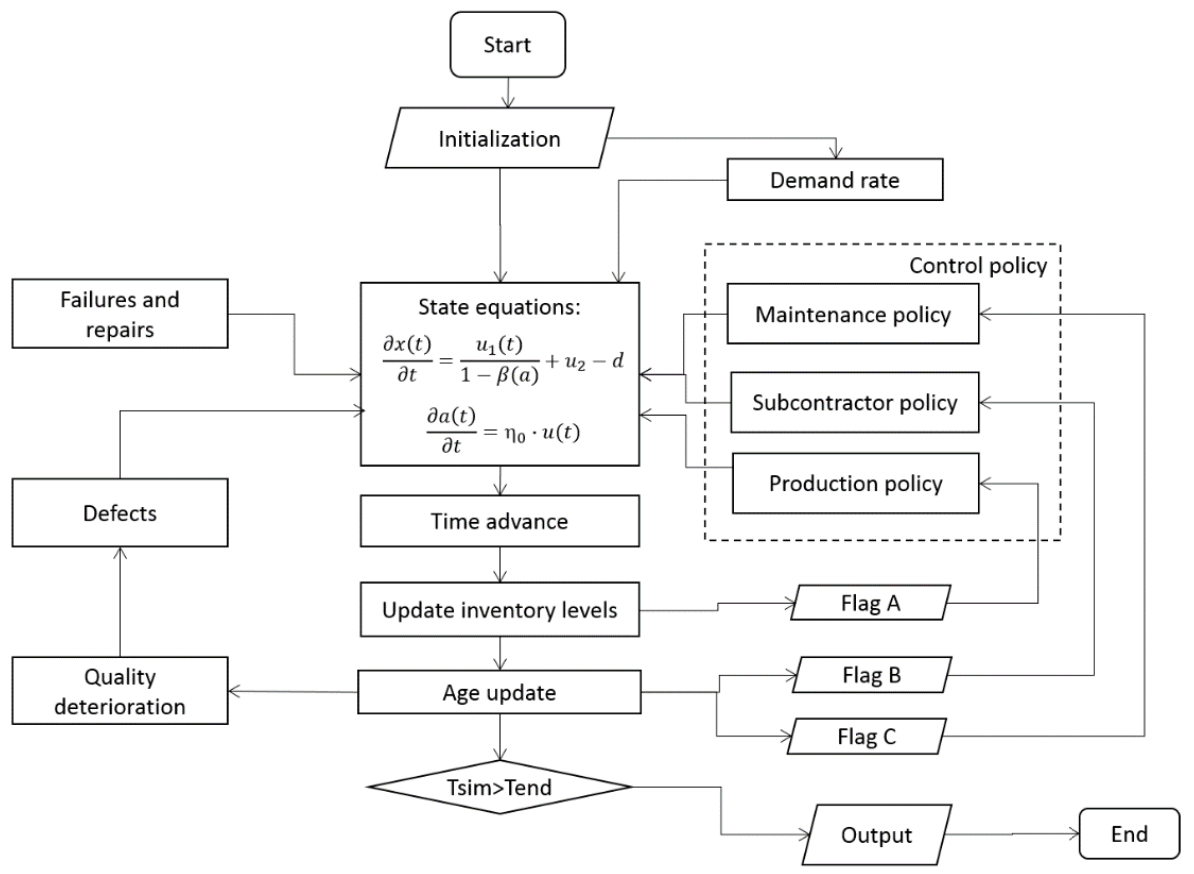
Figure 3. Logic for the simulation.